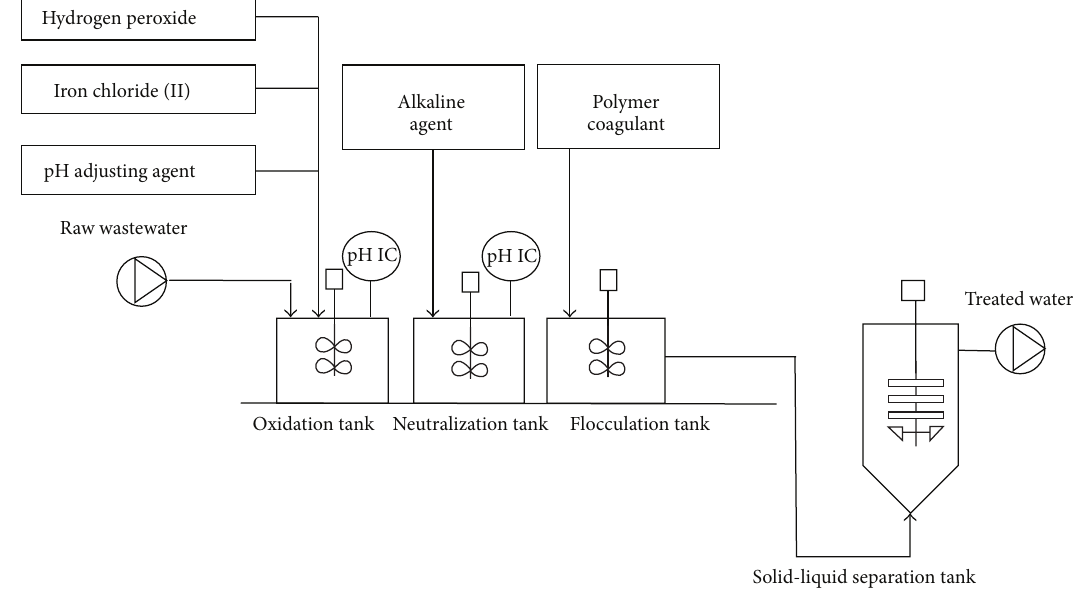
Figure 2: Treatment flow sheet for Fenton oxidation